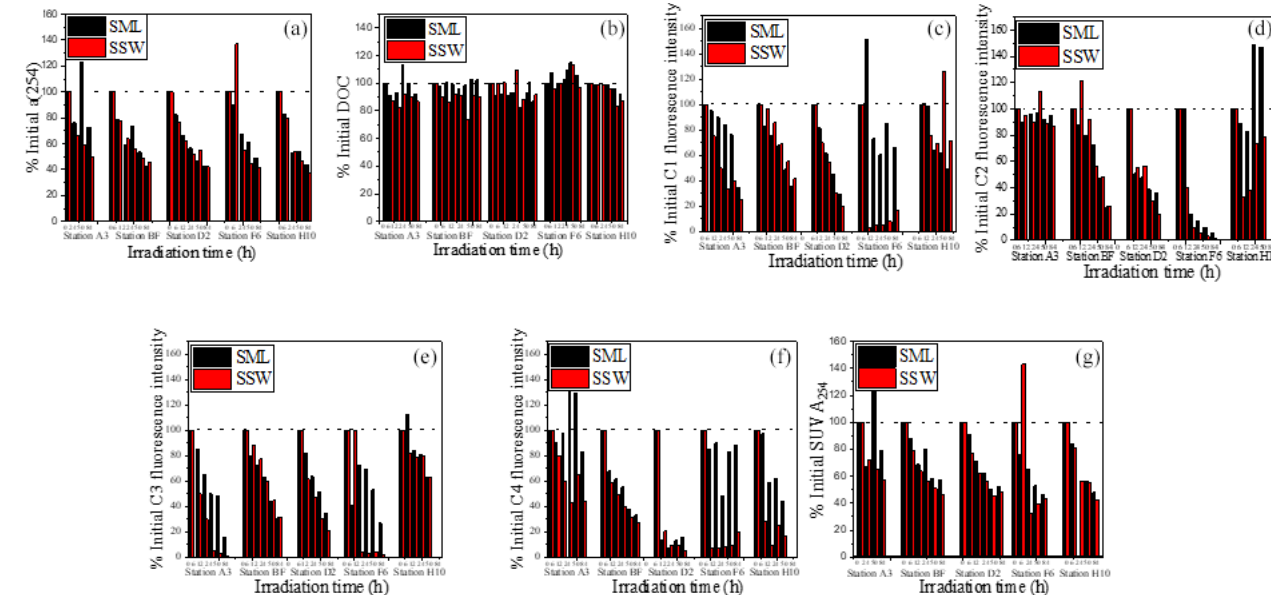
Figure 7. Changes in ratios of a (254), DOC, SUVA 254 and four fluorescence component intensities to initial values for both SML and SSW